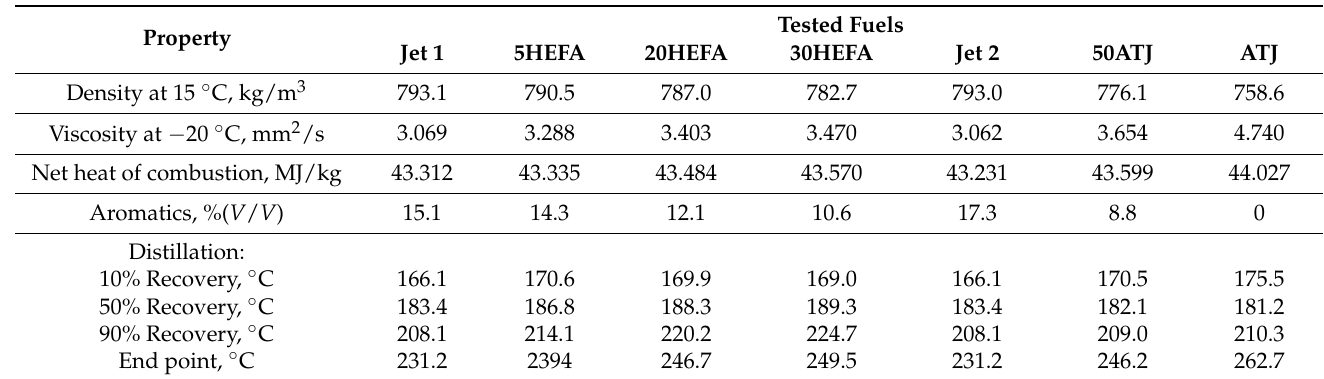
Table 1. Properties of tested